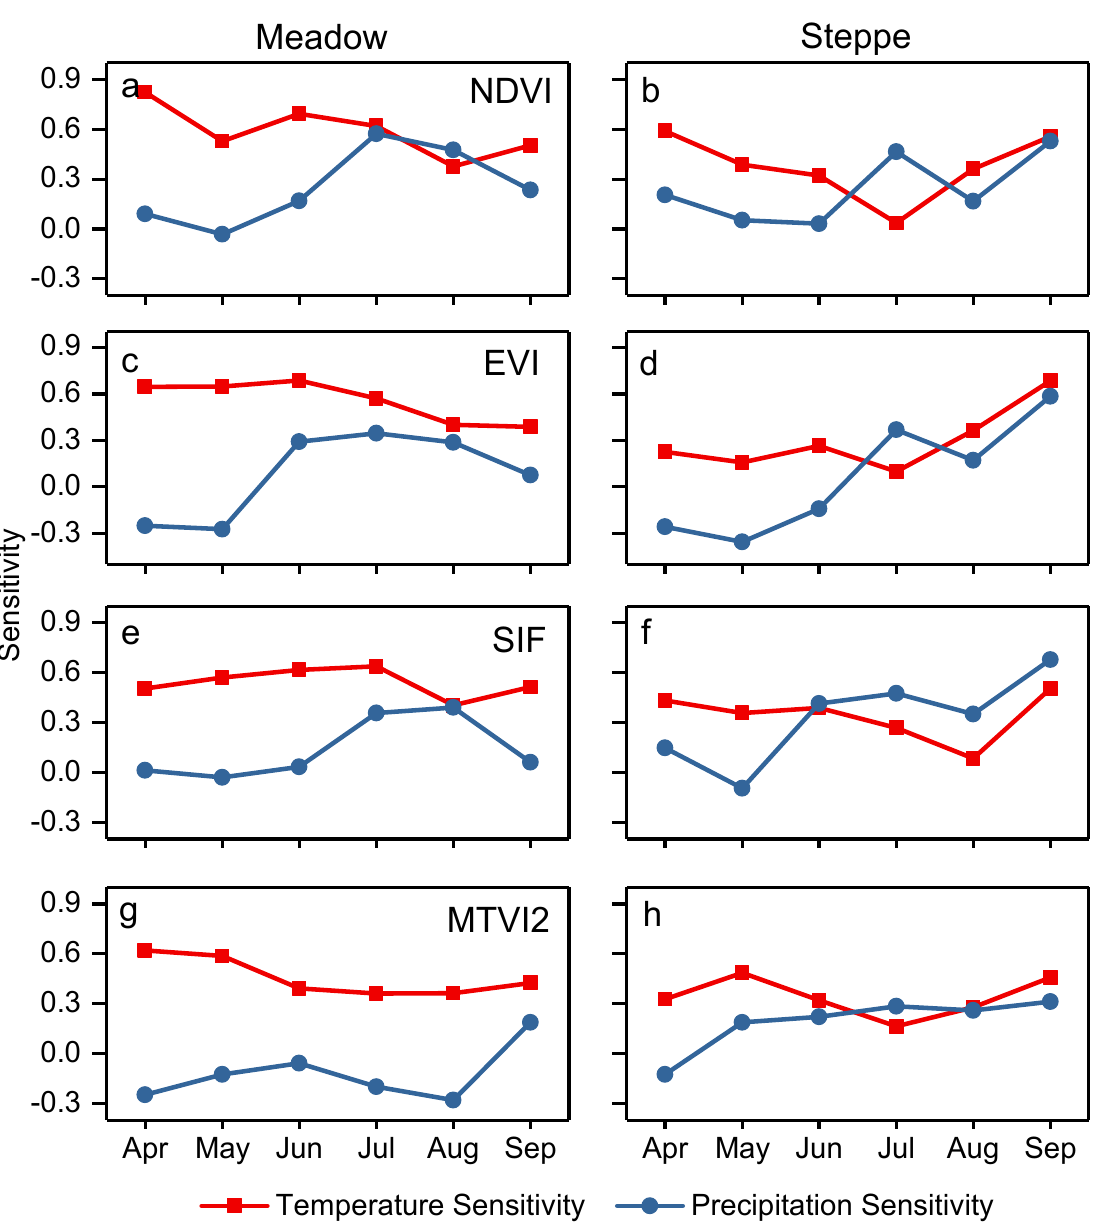
Figure 5. The temperature and precipitation sensitivity of intra-annual variability of the monthly vegetation indices in the meadow ( a ) NDVI; ( c ) EVI; ( e ) SIF; ( g ) MTVI2 and the steppe ( b ) NDVI; ( d ) EVI; ( f ) SIF; ( h ) MTVI2.